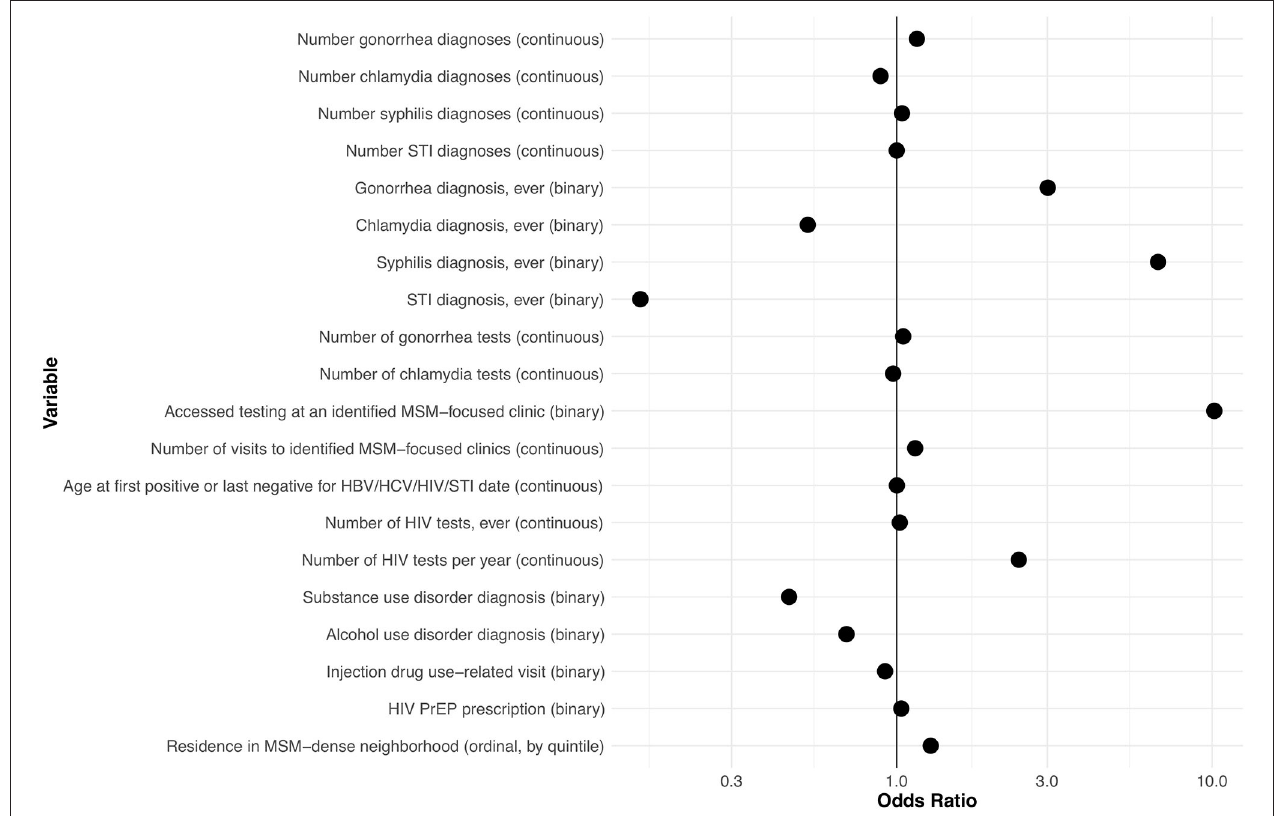
FIGURE 2 | Odds ratios for explanatory variables in a computable phenotype model for men who have sex with men within the British Columbia Hepatitis Testers Cohort. HBV, hepatitis B virus; HCV, hepatitis C virus; MSM, men who have sex with men; PrEP, pre-exposure prophylaxis; STI, sexually transmitted infection (see Supplementary Table 2 for detailed definitions of